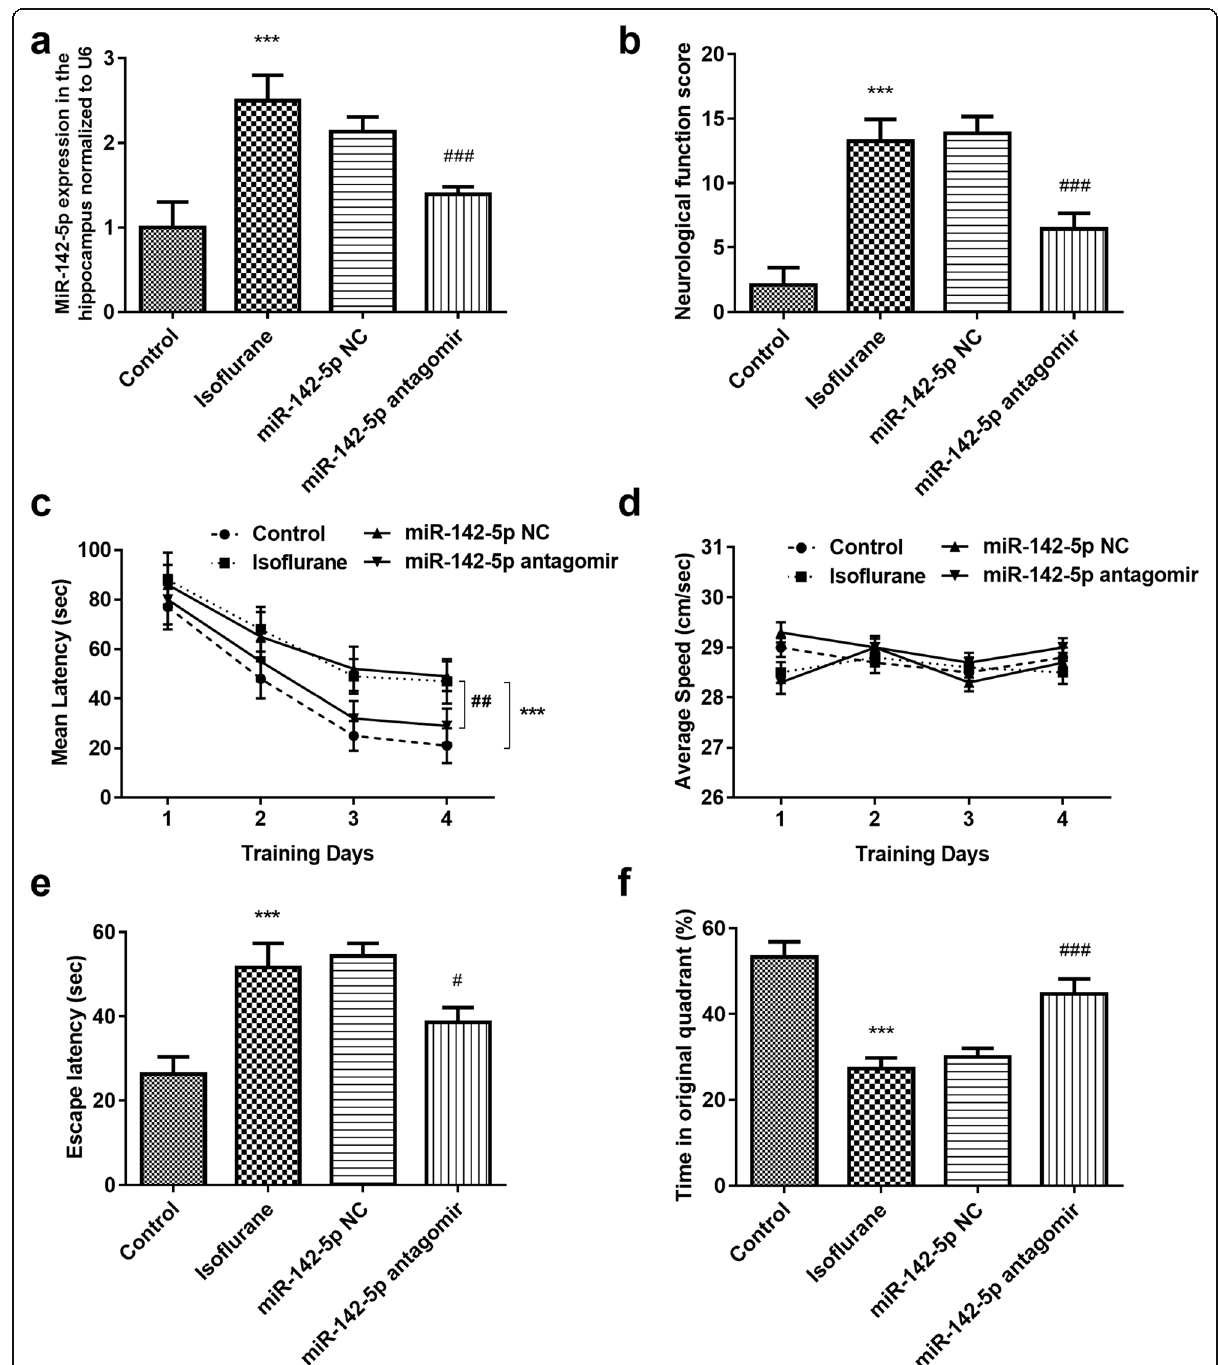
Fig. 3 The effect of miR-142-5p on isoflurane-induced neurological impairment. a The increasing trend of miR-142-5p expression induced by isoflurane treatment was significantly attenuated by the downregulation of miR-142-5p. b MiR-142-5p downregulation significantly reduced the neurological function score which was increased by isoflurane treatment. c-d MiR-142-5p downregulation significantly alleviated the influence of isoflurane on the latency time of rats during the spatial acquisition training time, but showed no significant influence on the swimming speed. e- f MiR-142-5p downregulation reversed the effects of isoflurane treatment on the escape latency and the time in the original quadrant at the end of learning. *** P < 0.001, compared with control group; # P < 0.05, ### P < 0.001, compared with isoflurane